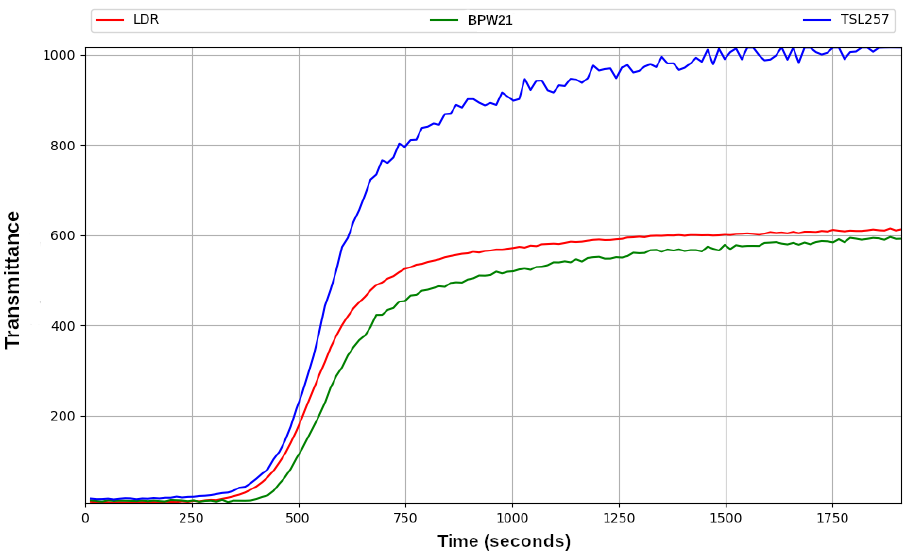
Figure 10. Transmittance behaviour of methyl red dye degradation recorded with three different sensors: LDR (red), BPW21 (green) and TSL257